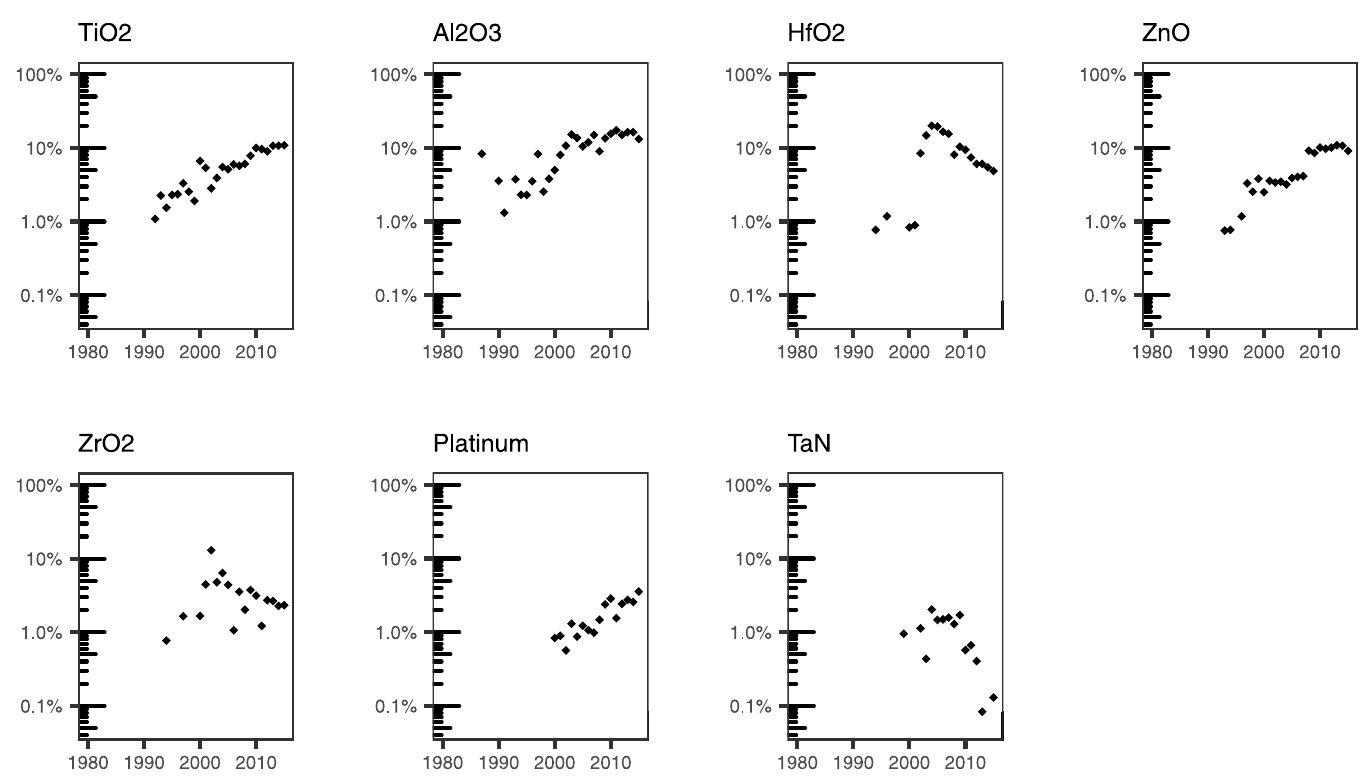
Fig 8. Percentage of ALD papers containing a specific word pertaining to materialsthat are likely to be grown by ALD in the titles.